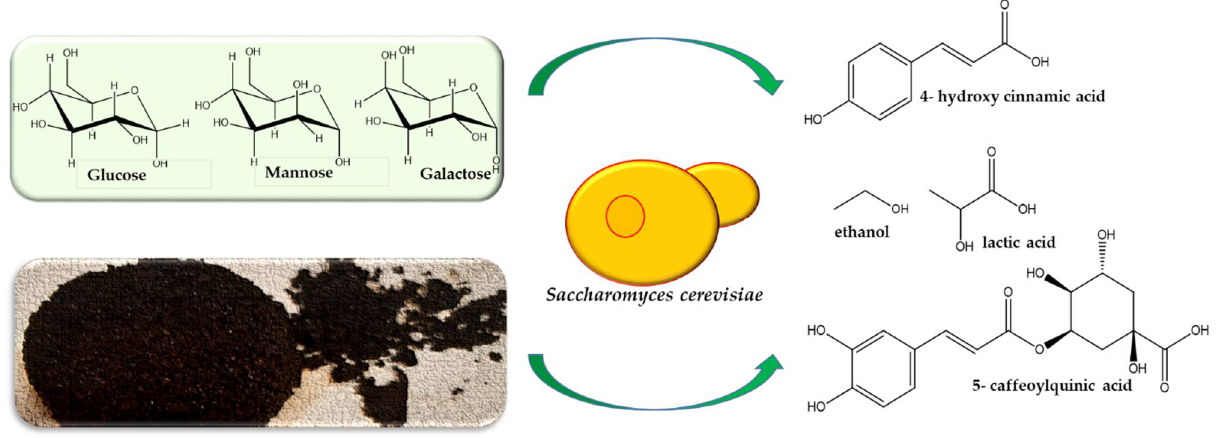
Figure 2. Capitalization of spent coffee waste. Appling different methods of treatment, the spent coffee waste (rich in glucose, mannose or galactose) can be turned into industrial by-products such as bioethanol, lactic acid or 5-cafeoylquinic acid.